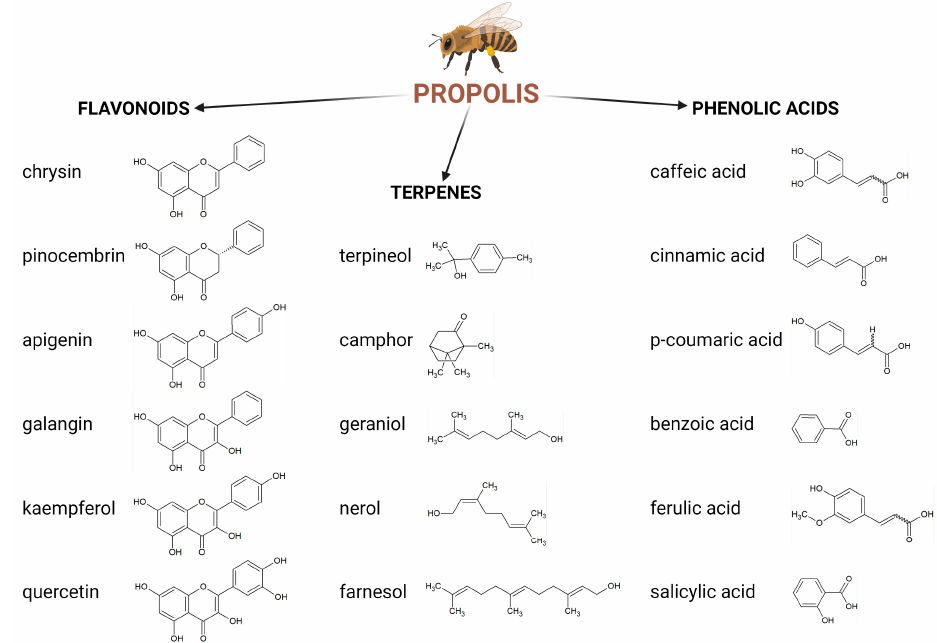
Figure 2. Main chemical compounds of propolis. Created with BioRender.com.